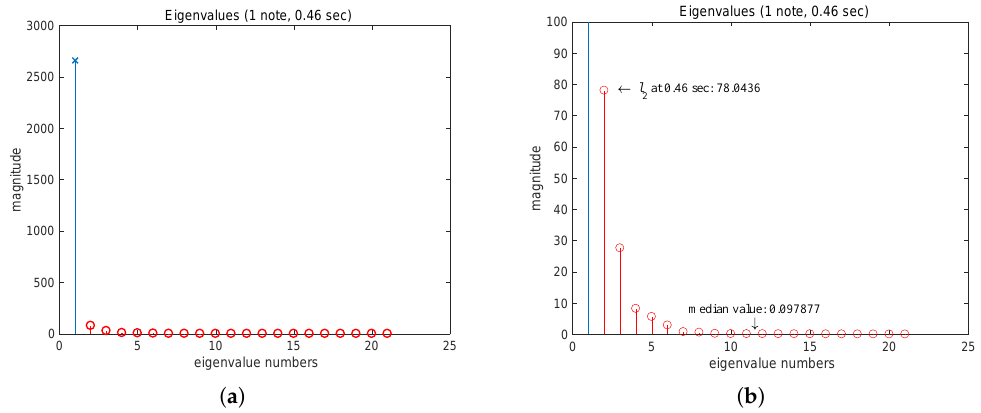
Figure 6. Eigenvalues of R v for the data from N p = 21: ( a ) Full-scale display, ( b ) scaled display for noise eigenvalues, where “x” denotes a signal eigenvalue and “o” denotes a noise